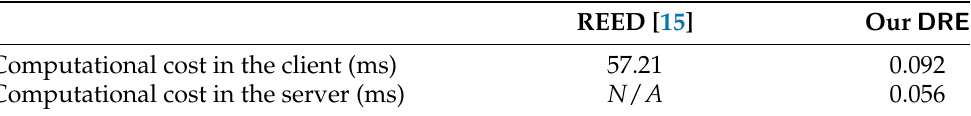
Table 3. Performance comparison between REED and our DRE. Note that the re-encrypted block is 64 bytes in